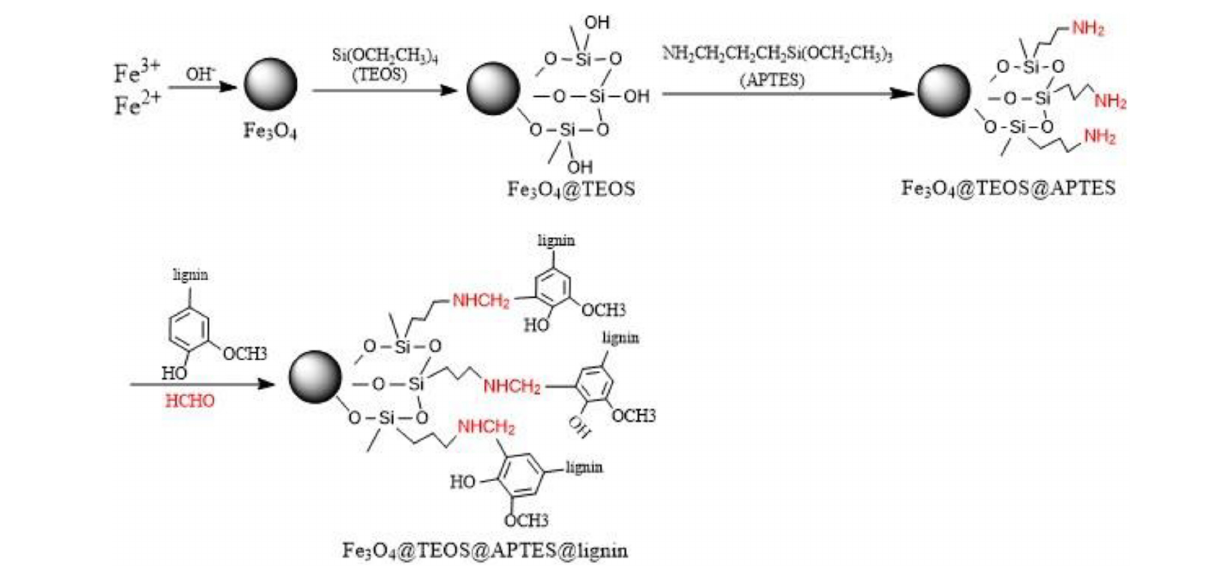
Frontiers in Bioengineering and Biotechnology |